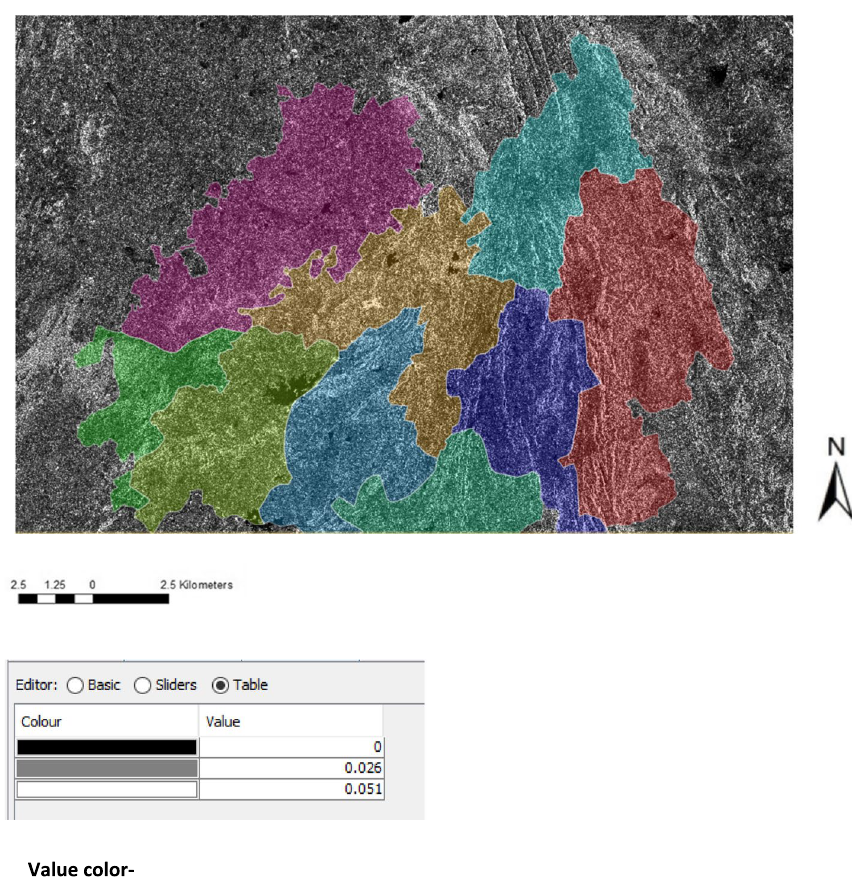
Fig. 7 Sentinel-1A-GRD calibrated data (VH Polarisation) of the Udaipur